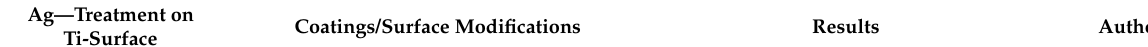
Table 1. Overview of available silver treatment for titanium dental